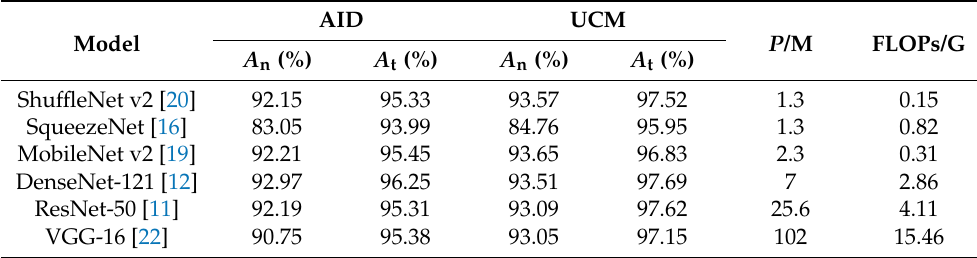
Figure 7. Comparison of training curves for each model with and without transfer learning. Table 2. Performance comparison of various backbone networks after using transfer learning. The training rate is 0.8. FLOPs is floating-point operations, and P is the number of parameters of the model. A n represents accuracy without using transfer learning and A t represents accuracy with transfer